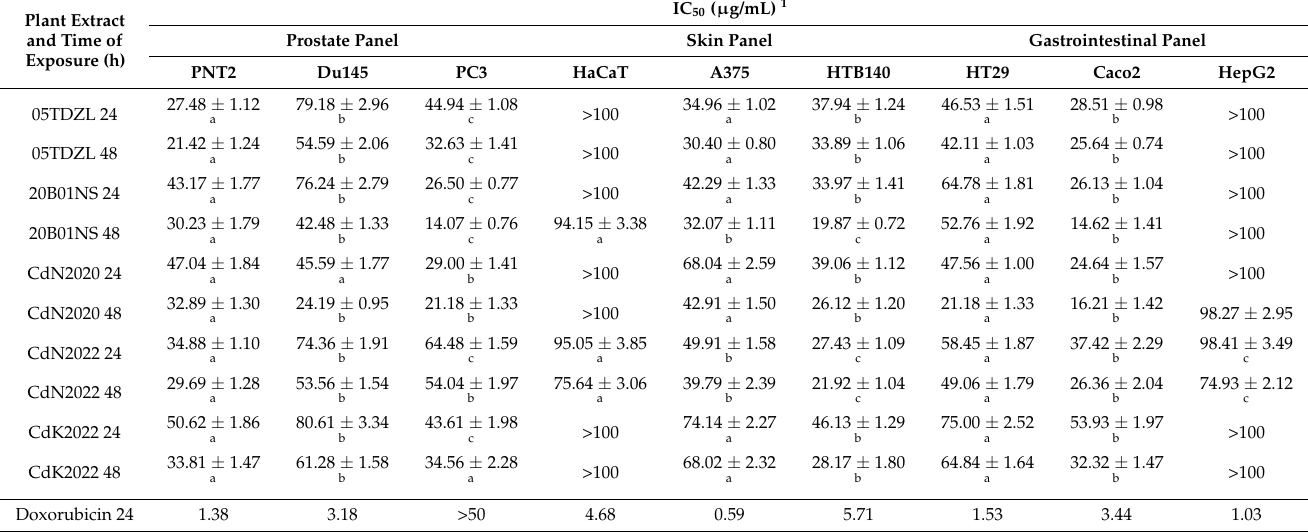
Table 3. Cytotoxic activities of extracts from in vitro- and field-grown Carpesium divaricatum , after 24 and 48 h. Doxorubicin was used as a reference cytostatic; 05TDZL—plants cultivated in a liquid MS medium containing 0.5 µ M TDZ; 20B01NS—plants cultivated on a solidified MS medium